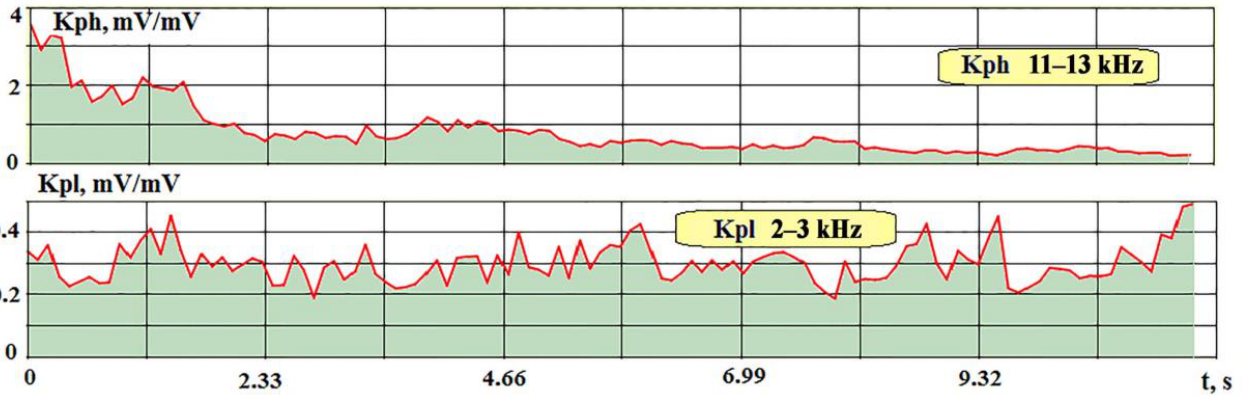
Figure 12. Changes in transmission coefficients at high and low frequencies from the moment of embedding to the break of the wire electrode during HS123 hard alloy WEDM: transmission coefficient K p h for the 11–13 kHz range (upper graph); change in the K p l coefficient for the 2–3 kHz range (lower graph).